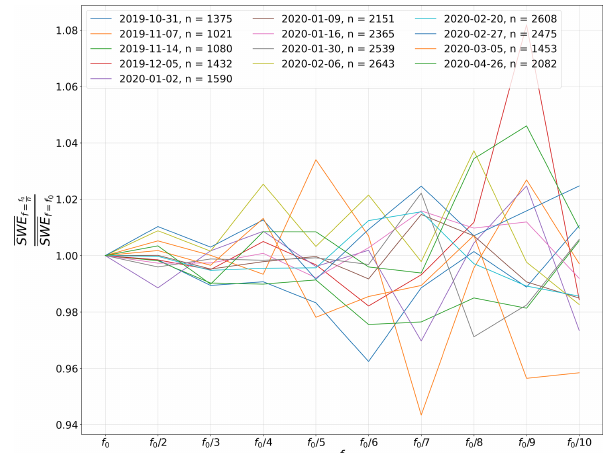
Figure 6. Sensitivity of the transect average as a factor of the Mag- naprobe horizontal sampling. The x axis shows the horizontal tran- sect sampling frequency in relation to the original sampling fre- quency f 0 , and the y axis shows the ratio of the average SWE of all tested frequencies to the average SWE of the original sam- pling frequency for each day of sampling (31 October 2019